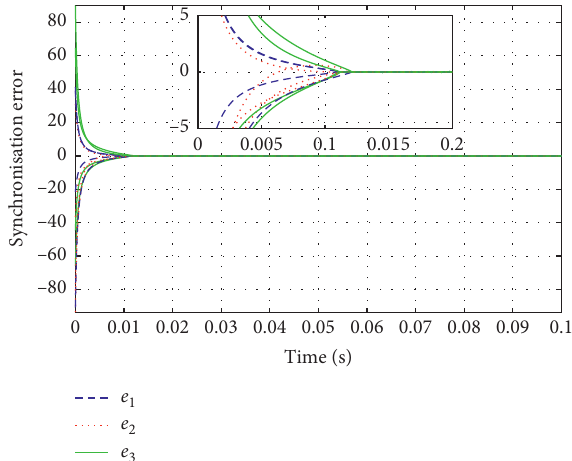
Figure 7: Synchronization error for several different initial con- ditions with the predefined-time T c � 0 .